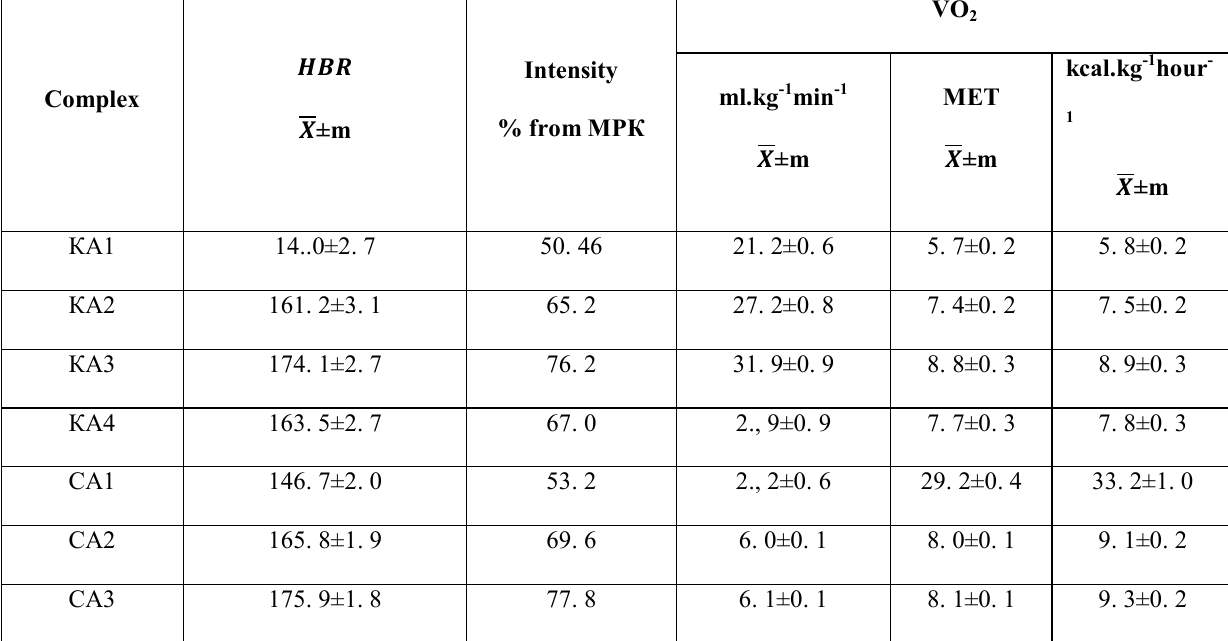
Pulse responses and oxygen consumption during fulfillment of aerobic experimental complexes by